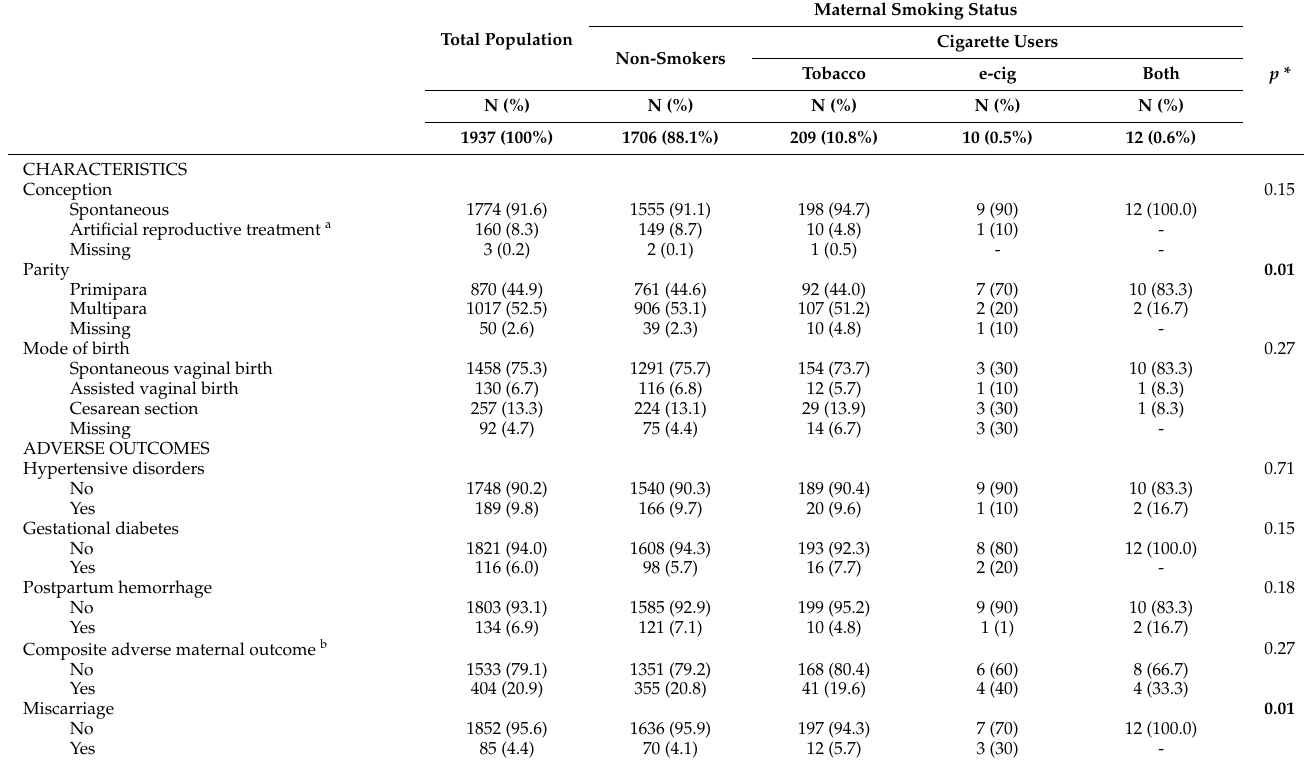
Table 2. Maternal characteristics and outcomes by smoking